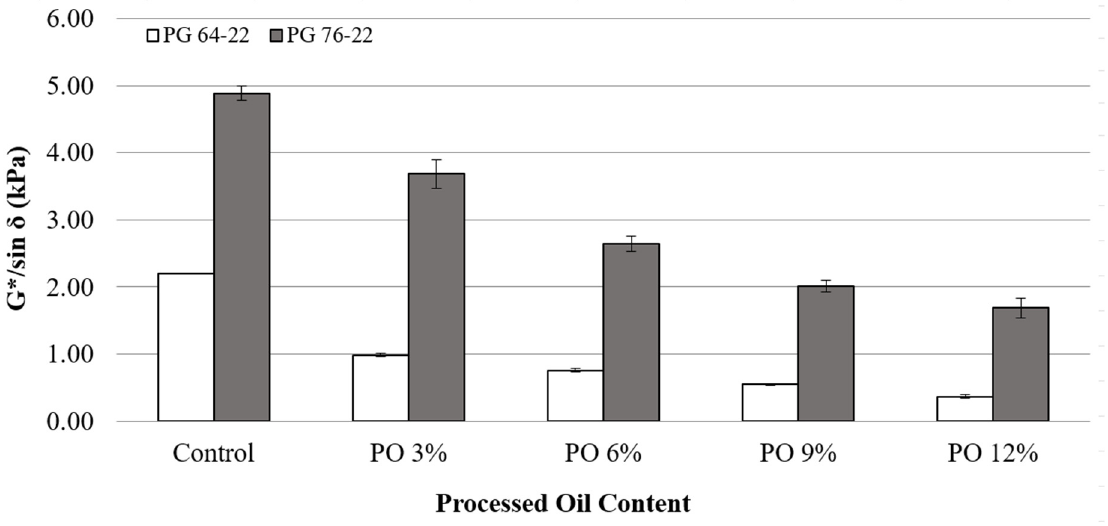
Figure 5. G*/sin δ of the original asphalt binders with processed oil at 64 °C. Table 5. Statistical analysis results of the G*/sin δ as a function of processed oil content ( = 0.05).